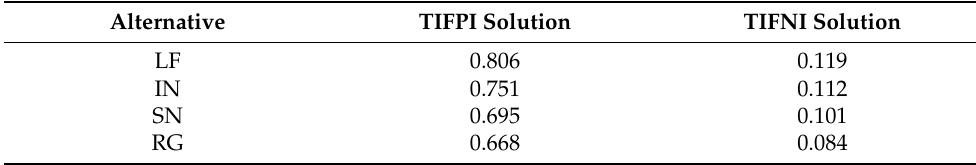
Table 6. The intuitionistic fuzzy positive and negative ideal